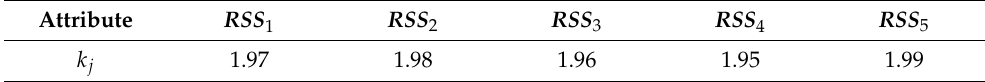
Table 5. The discrimination threshold values, k